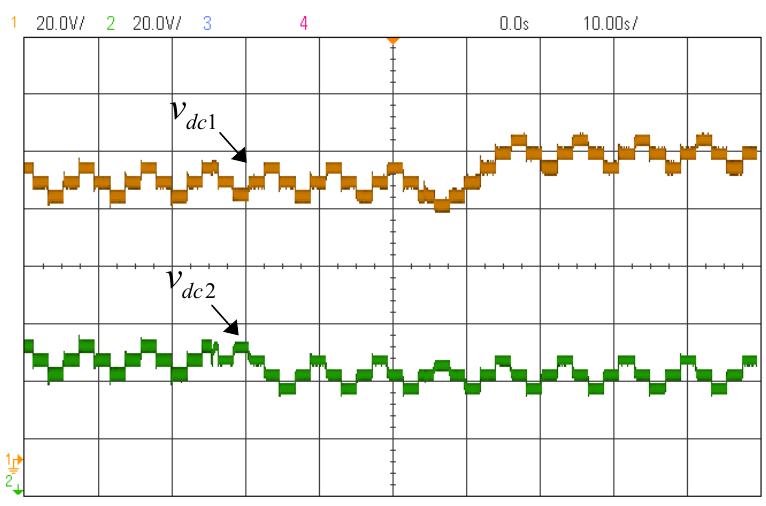
Figure 15. Experimental dynamic operation of DC-link voltage under unbalanced power per string due to solar irradiation and temperature changes.